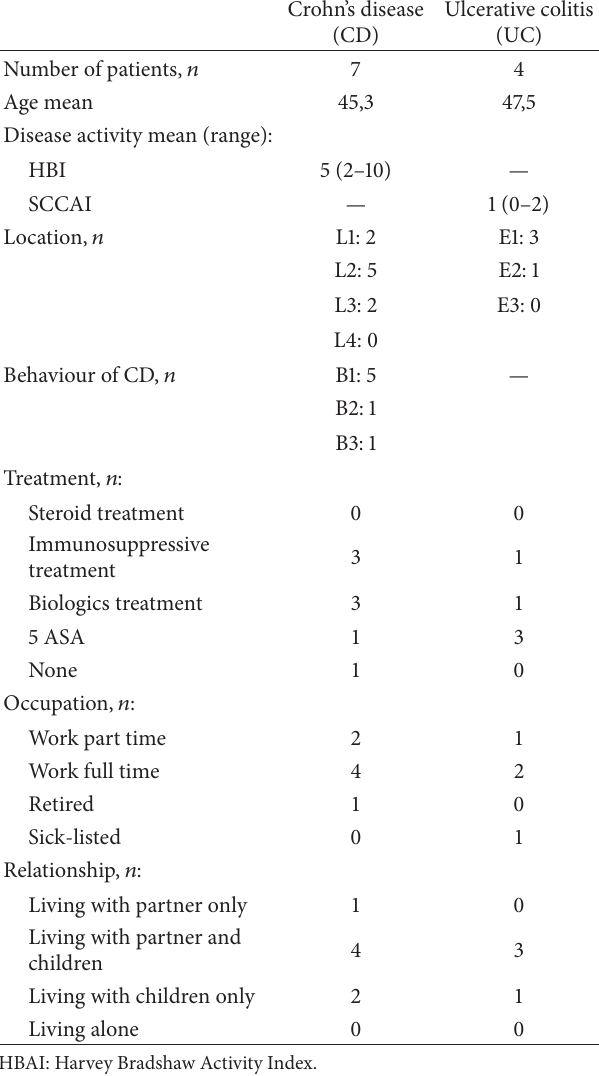
Table 1: Demographic characteristics of included patients.